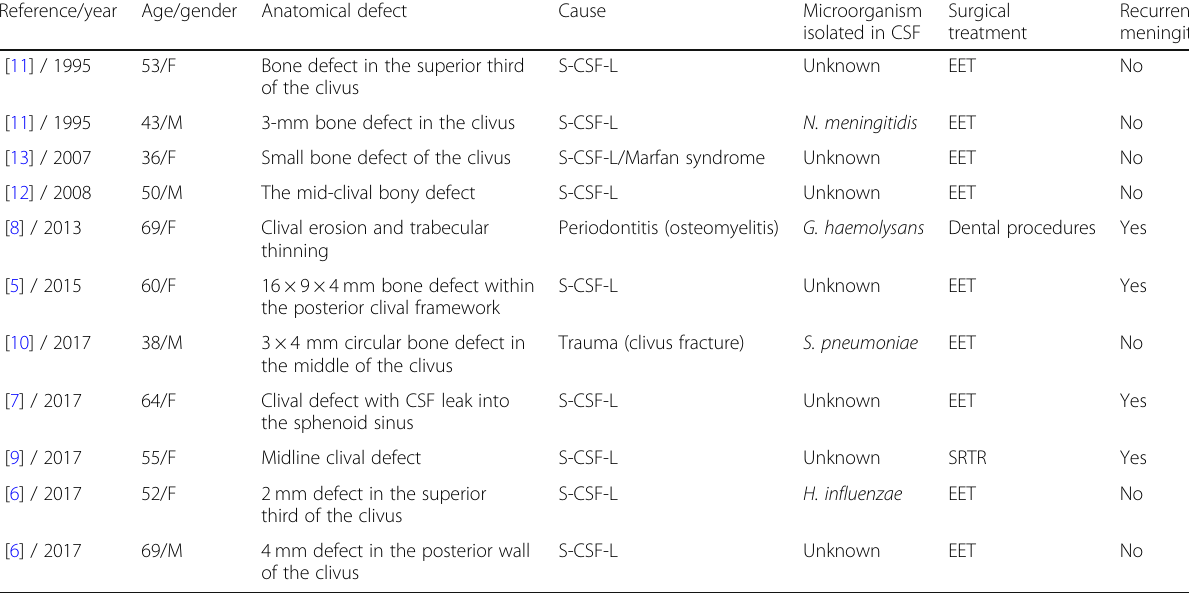
F female, M male, CSF cerebrospinal fluid, S. aureus Staphylococcus aureus , S. pneumoniae Streptococcus pneumoniae , G.haemolysans Gemella haemolysans , H. influenzae Haemophilus influenzae , N. Meningitidis Neisseria meningitidis , S-CSF-L spontaneous CSF leakage, EET endoscopic endonasal transsphenoidal surgery, SRTR sublabial rhinoseptal transsphenoidal